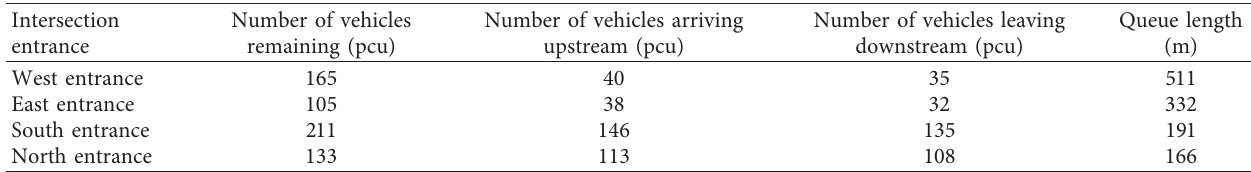
Table 4: The average queue length of each entrance at the